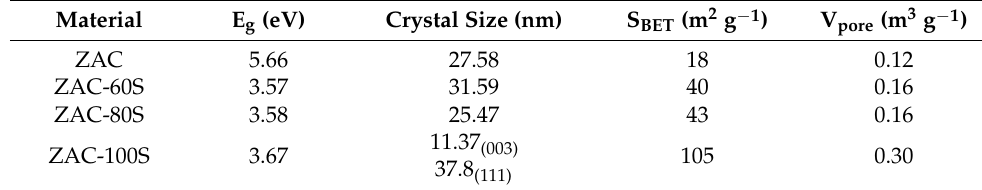
Table 2. Determinant parameters for photocatalytic performance.